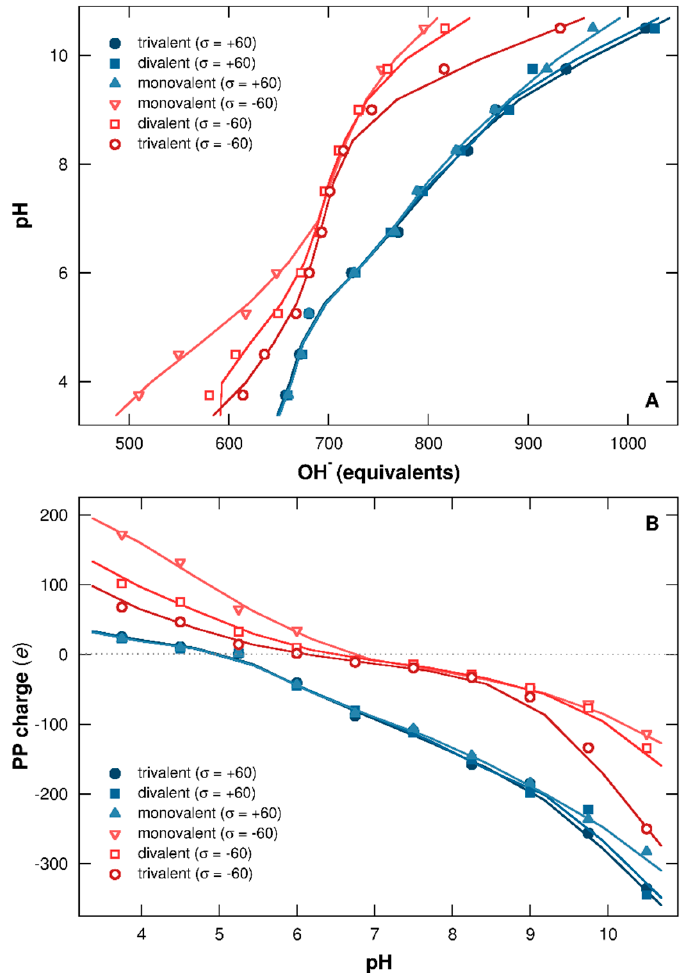
Figure 6. ( A ) PP titration curves (pH as a function of OH - equivalents) and ( B ) total charges per chain (in elementary charges). NP surface charge densities are − 60 (red open symbols) and +60 (blue closed symbols) mC/m 2 . Monovalent counterions and salt with variable valencies (+1, +2, or +3) are considered. Ionic strength is fixed to 1 × 10 − 4 M.